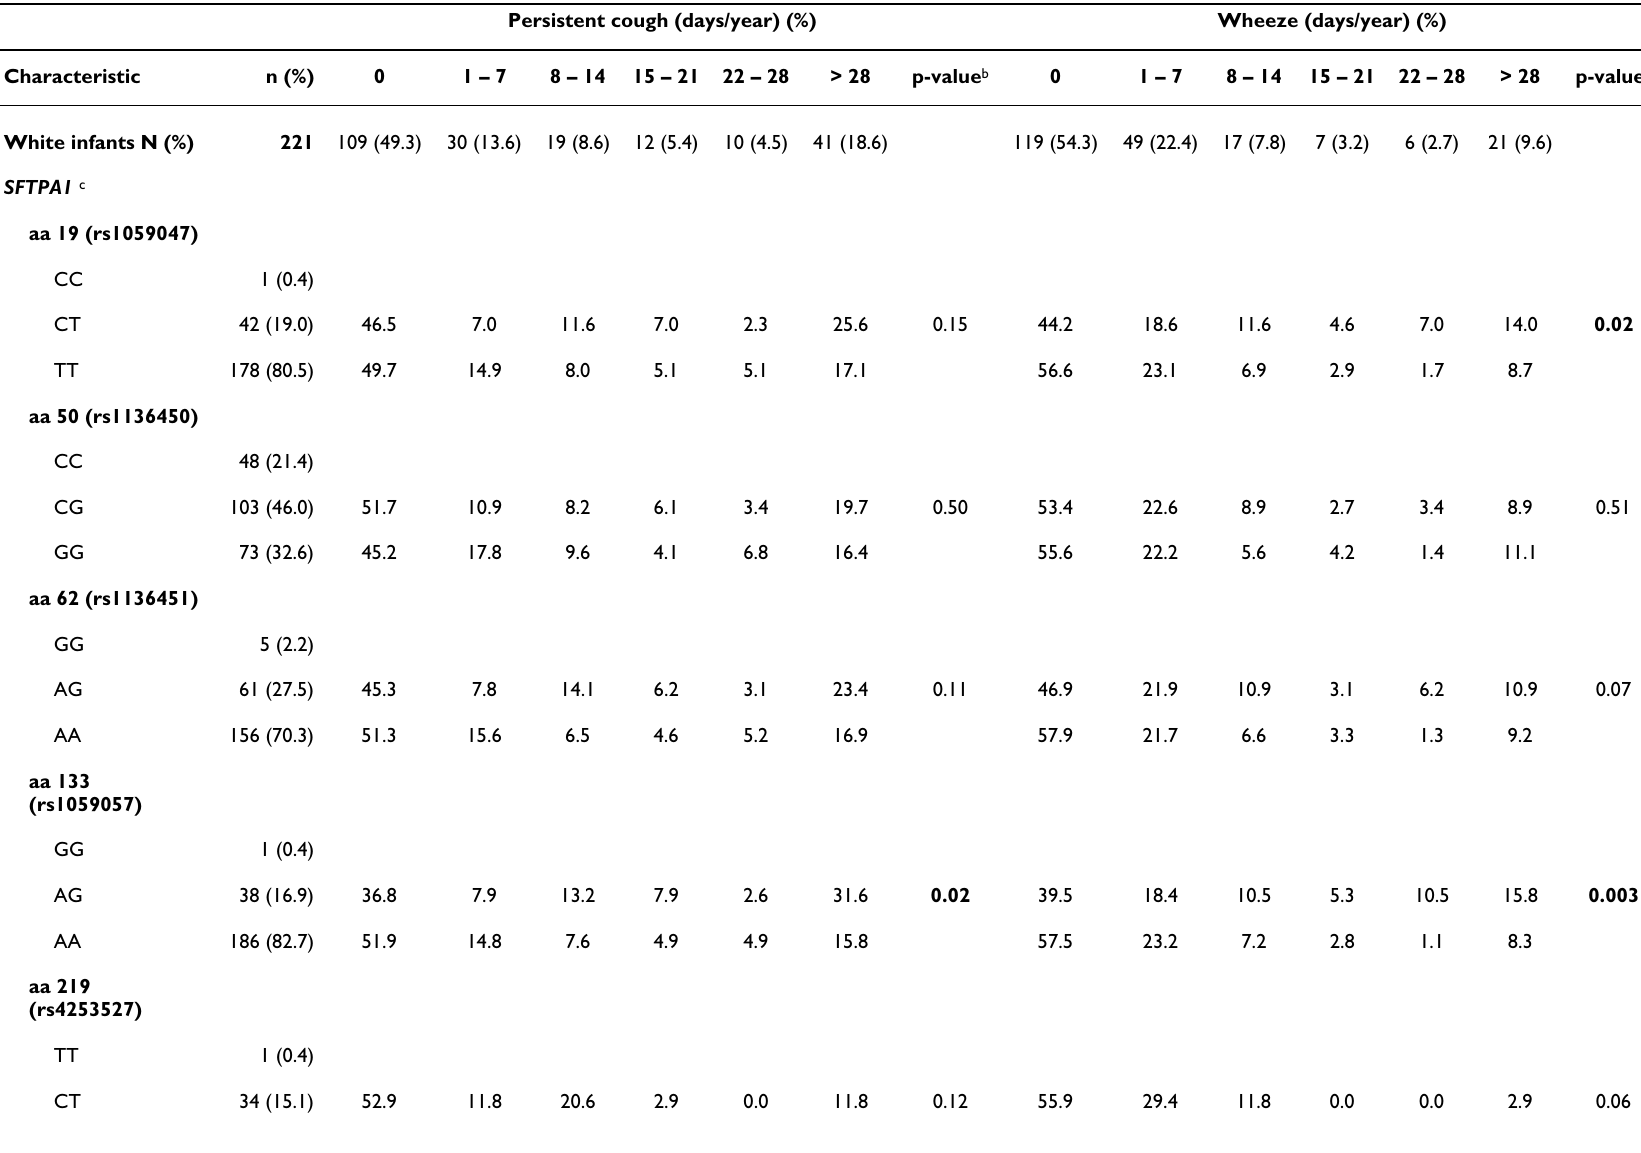
developing asthma. (CT and MA, 1998 –